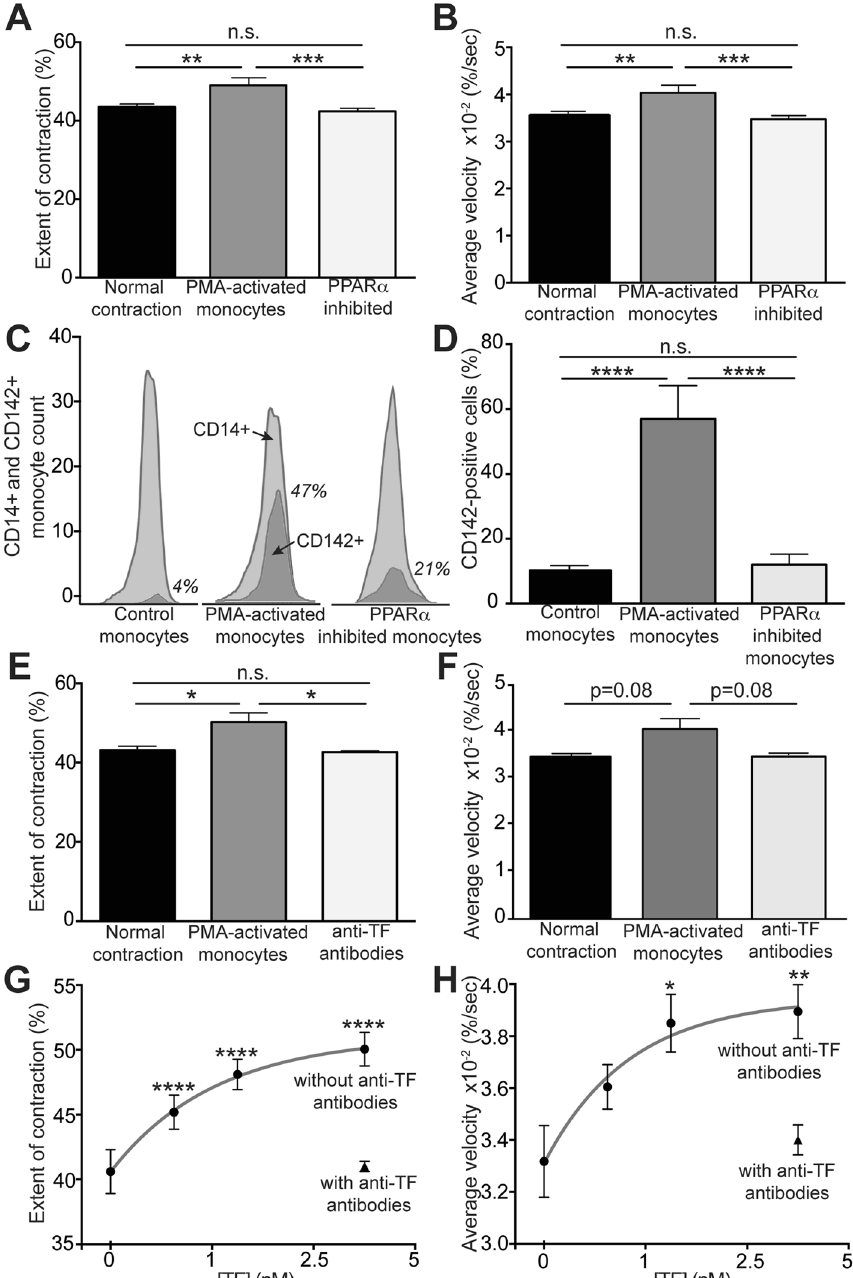
Figure 2. Effects of cell-expressed or purified TF on clot contraction. ( A ) Average extent of clot contraction and ( B ) average velocity of clot contraction at 20 minutes after addition to whole blood of non-activated monocytes (normal contraction), PMA-activated monocytes, and PMA-activated monocytes treated with a PPAR α agonist, an inhibitor of TF expression, prior to PMA activation (n = 24). ( C , D ) The fraction of TF-expressing (CD142- positive) monocytes determined by flow cytometry in the CD14-positive monocyte populations under various experimental conditions indicated. ( C ) Raw flow cytometry peaks from a representative experiment are shown. The monocyte population is shown in light gray peaks, while the fractions of TF-expressing monocytes are shown in dark gray peaks and numbers in italics . ( D ) The average percent of TF-expressing monocytes under various experimental conditions indicated (n = 3). ( E ) Average extent of clot contraction and ( F ) average velocity of clot contraction at 20 minutes after addition to whole blood of non-activated monocytes (normal contraction), PMA-activated monocytes and PMA-activated monocytes treated with inhibitory anti-TF antibodies (n = 3). (G) Average extent of clot contraction and (H) average velocity of clot contraction at 20 minutes after addition to whole blood of lipidated TF at a final concentration of 1 pM, 2.5 pM, and 5 pM fitted with an exponential (n = 4). The results are presented as mean ± SEM. * p < 0.05, ** p < 0.01, *** p < 0.001, **** p <